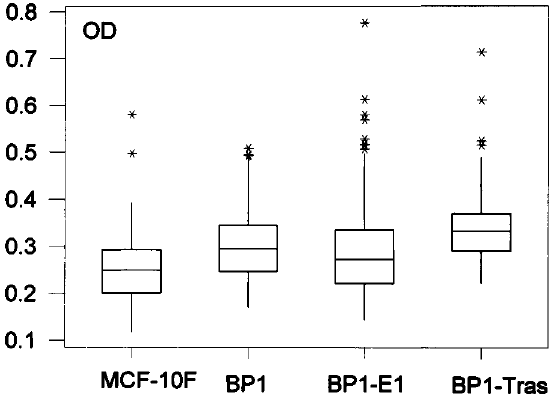
Fig. 4. Tukey’s box-and-whisker plots for nuclear absorbing ar- eas of Feulgen-stained MCF-10F cell lines. Lower and upper traces = lower and upper quartiles of the distributions; middle trace = median; (cid:3) = outliers. The plot for BP1-E1 cells was based on values obtained previously